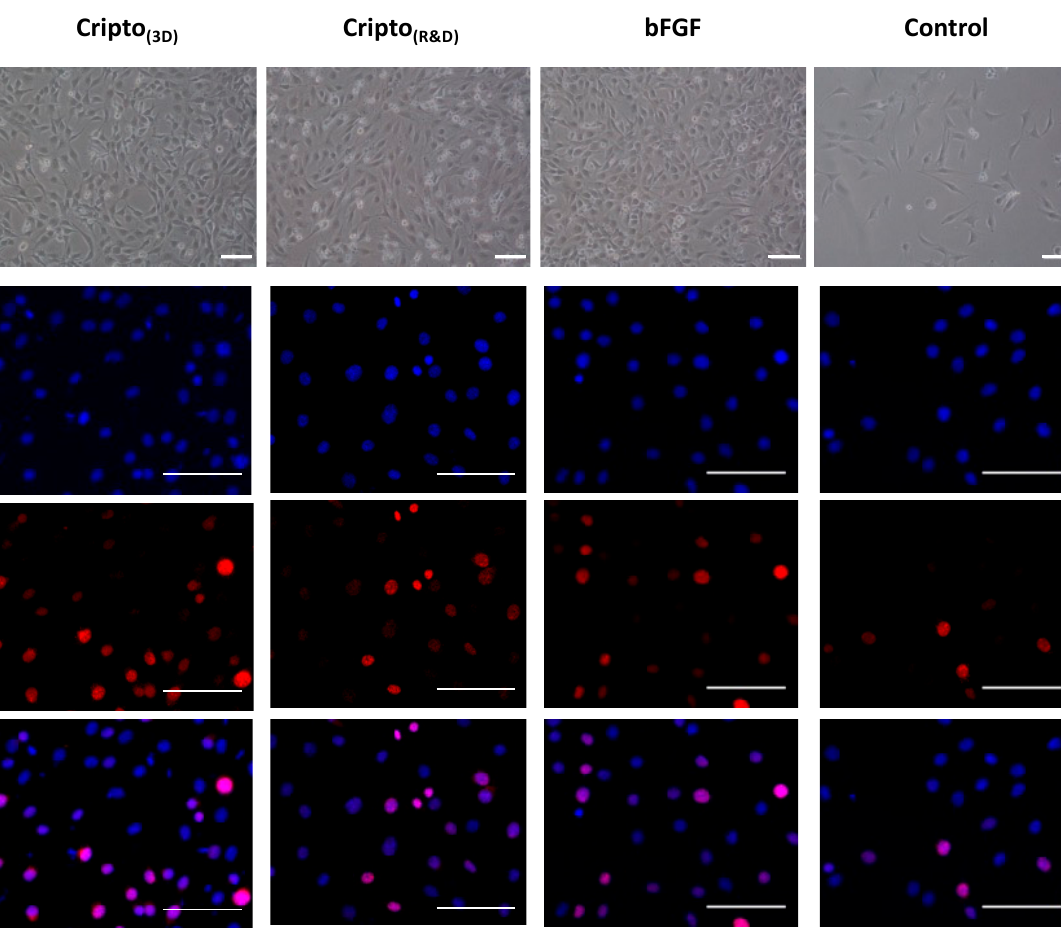
Figure 5. Proliferation analysis using Ki67 immunostaining of C2C12 myoblasts after treatment with Cripto produced in 3D microcarriers. C2C12 myoblast proliferation was evaluated by a Ki67 im- munostaining assay after being cultured for 48 h in serum-free medium containing Cripto produced in 3D microcarriers (Cripto (3D) ) or commercially available Cripto (Cripto (R&D) ). Also evaluated were a bFGF medium positive control and a serum-free medium negative control. ( A ) Representative bright fi eld images of myoblasts showing the morphology of the cells in the di ff erent treatments. Fluorescence staining for the cell proliferation marker Ki-67 (red) is shown for the di ff erent